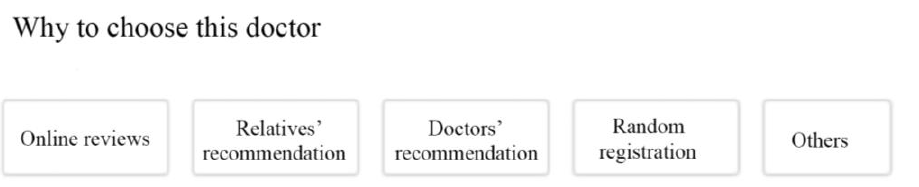
Figure 3. Selection reasons.